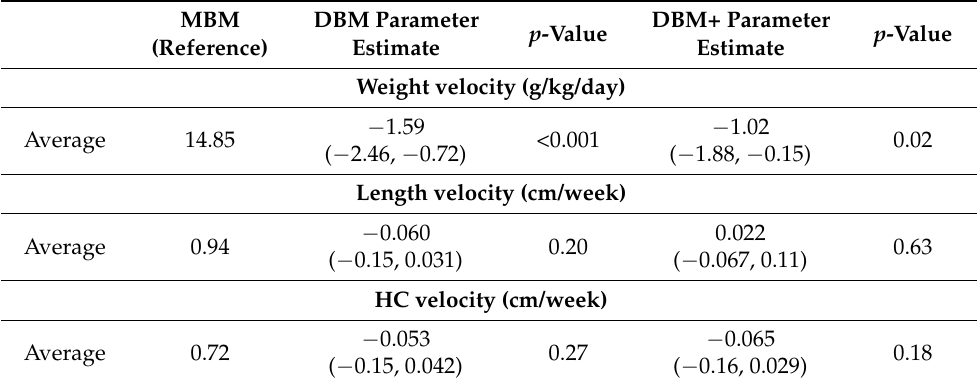
Table 6. Linear model of growth velocity comparisons between groups, adjusted for SGA, with MBM as reference.